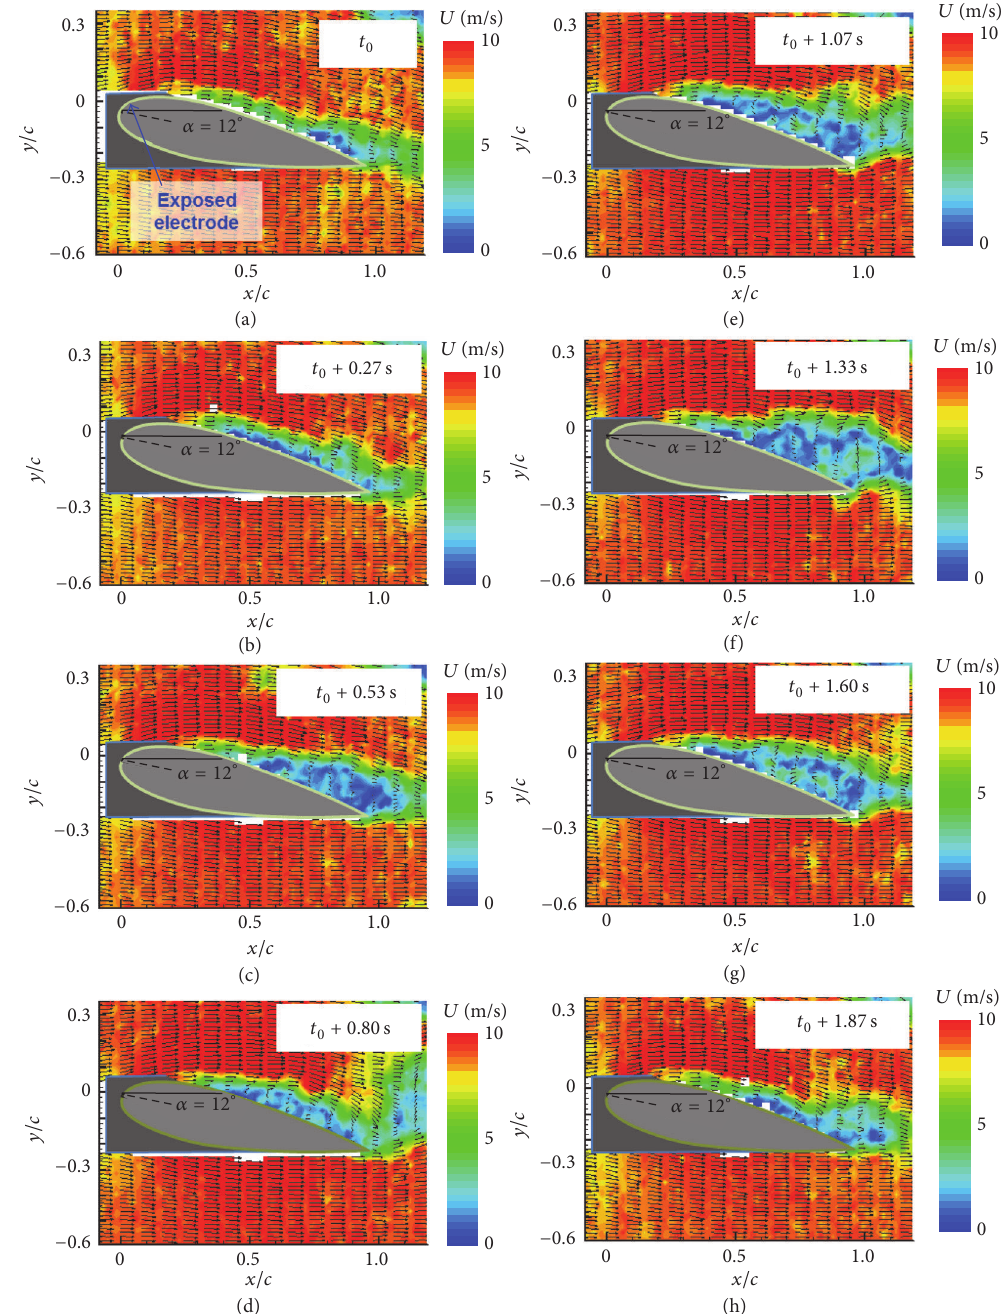
Figure 13: A series of instantaneous velocity distributions ( 1/3.75 ≈ 0.27 s intervals) measured by PIV, with periodic wall oscillation under PA-OFF conditions. The main flow was separated dynamically from the NACA0024 airfoil in sync with the wall